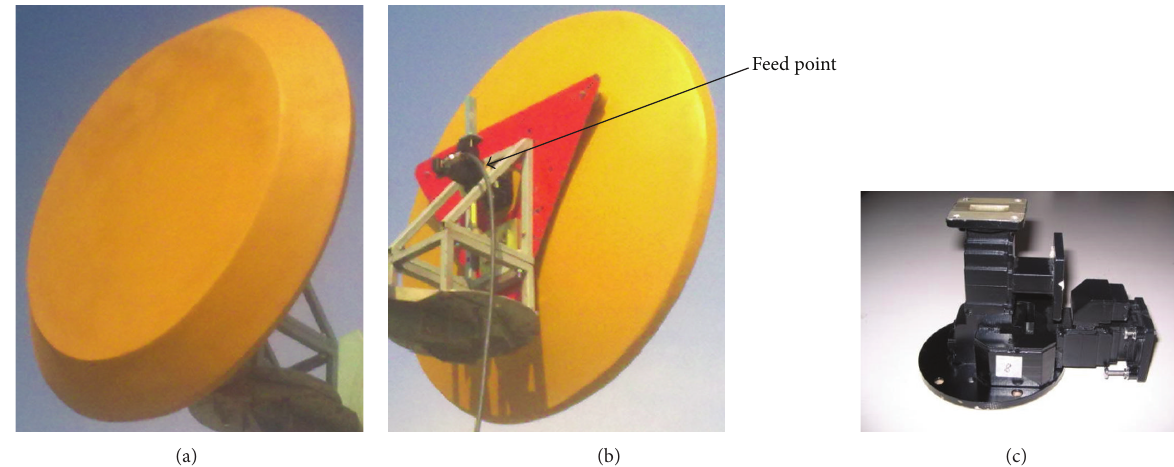
Figure 8: The manufactured cassegrain antenna under far field pattern test (free space); (a) front view; (b) back view; (c) its 4-horn array antenna feed with sum and difference port without radome (used for better efficiency).